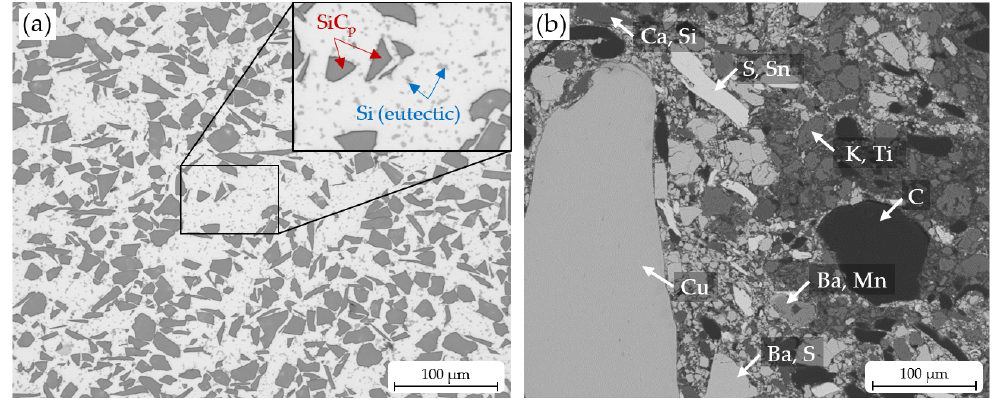
Figure 1. ( a ) The microstructure of a FAST sintered AMC reinforced with 35 vol.% SiC p shows a regular distribution of particles, which are mainly responsible for the high wear resistance. The SiC p (marked with red arrows) can be easily distinguished from eutectic silicon phase (marked with blue arrows) of the AlSi7Mg matrix alloy regarding their shape, size, and greyscale value. ( b ) A typical SEM image of the counterbody, a semi-metallic brake lining material, is shown with elements determined at points by EDX measurement. An EDX analysis of the whole area gave the following results (qualitative): Ba, Ca, Cu, K, Mg, Mn, S, Si, Sn, Ti, V, Zn, and Zr.